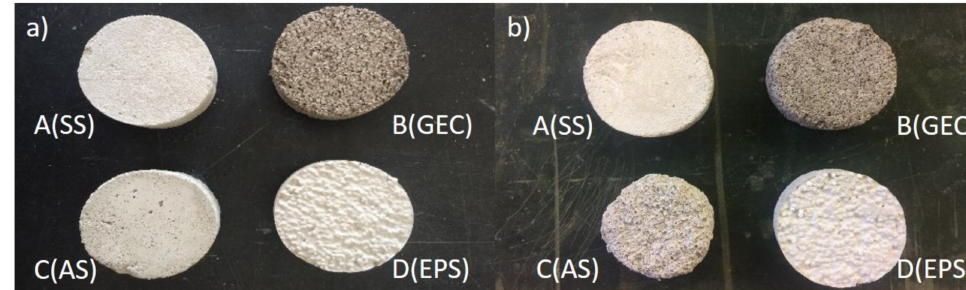
Figure 7. Specimens for thermal conductivity evaluation after hygrothermal and IR accelerated aging cycles: ( a ) before; ( b )